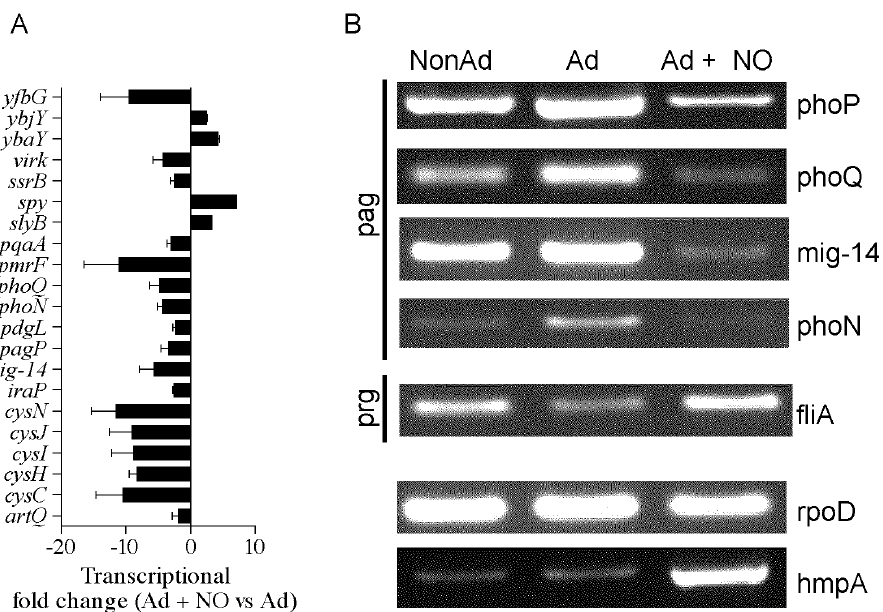
Figure 5. Acid-inducible PhoPQ-dependent gene transcription is repressed by RNS. Panel A shows the expression of PhoP-activated genes in rapidly growing Salmonella cultured for 1 h in EG medium, pH 4.4 in the presence (Ad + NO) or absence (Ad) of 250 m M spermine NONOate. Microarray data are represented as the mean fold change 6 SD from 3 independent experiments. (B) Transcription of PhoP-activated genes (pag), PhoP-repressed genes (prg), the control housekeeping rpoD gene and the NO-inducible hmpA gene were assessed by RT-PCR of RNA isolated from NonAd, Ad, and Ad + NO bacterial cultures grown as described in figure 1.